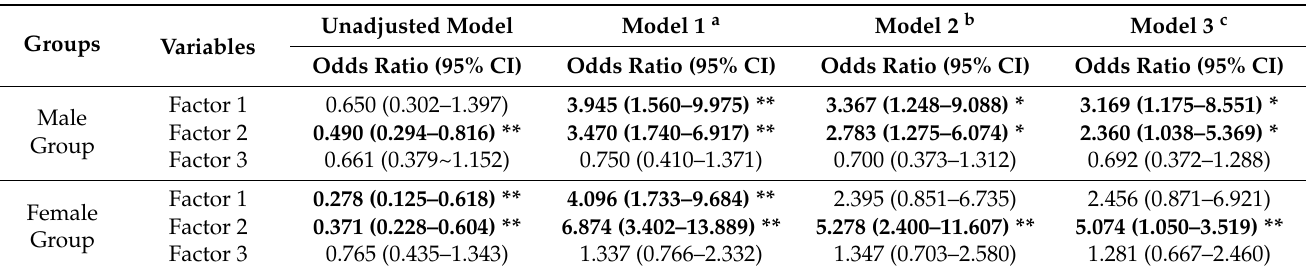
Table 5. Results of univariate multiple logistic regression analysis for each model according to adjustment variables in the male and female groups. Each model used three factors contained by factor rotation as independent